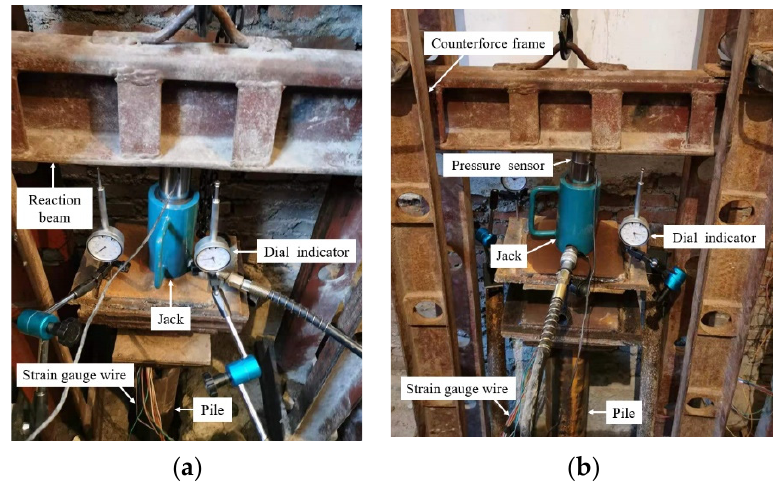
Figure 2. Schematic diagram of the pile-end soilless compressive pile.